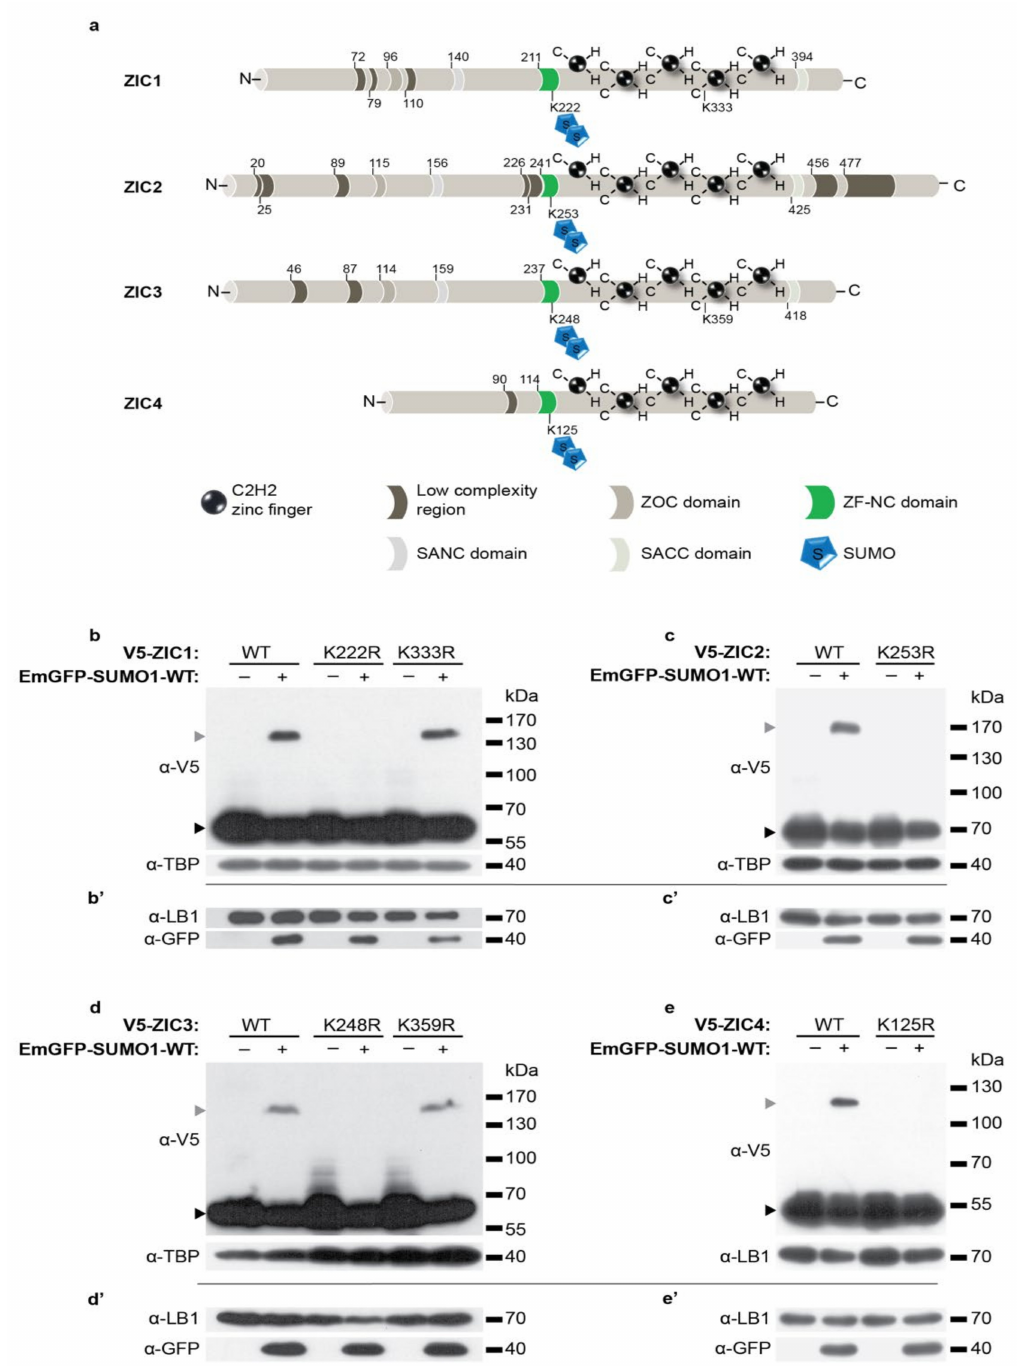
Figure 1. ZIC proteins are SUMOylated within the ZF-NC domain. ( a ) Schematic of human ZIC1-4 showing the SUMO attachment site. ( b , c , d , e ) Representative WBs of HEK293T cell nuclear fractions following transfection with the V5 epitope- tagged ZIC expression plasmid shown, with or without EmGFP-tagged SUMO1-WT expression construct. ( b ) ZIC1, ( c ) ZIC2, ( d ) ZIC3, and ( e ) ZIC4. The SUMO-dependent higher-molecular-mass form of each protein is not produced when the putative target lysine (K) within the ZF-NC (ZIC1 K222, ZIC2 K253, ZIC3 K248, and ZIC4 K125) is changed to an arginine (R), indicating these are the sole site of SUMO attachment in each protein. The higher-molecular-mass protein is produced when the other putative target lysines are altered (ZIC1 K333 and ZIC3 K359), indicating that these lysines are not a SUMO target. Gray arrow, SUMOylated ZIC; black arrow, basal ZIC. ( b ’, c ’, d ’, e ’) WB to show overexpressed EmGFP-SUMO1-WT protein and corresponding loading control. For each protein, n = 3 independent transfections and WB. For WB of nuclear fractions (using antibodies against V5 or GFP), antibody against TBP or Lamin B1 (LB1) was used as a loading control,